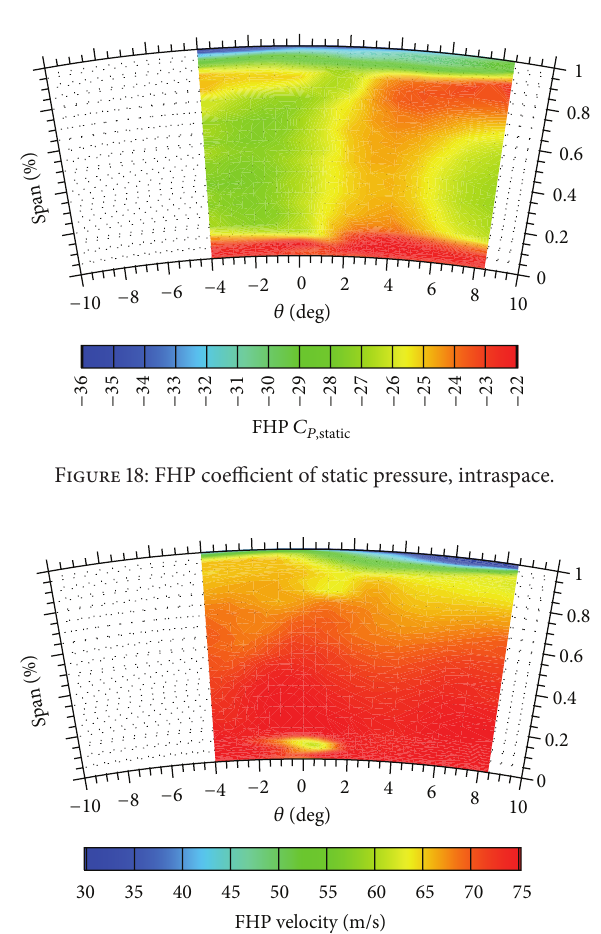
Figure 19: FHP velocity measurement, intraspace.